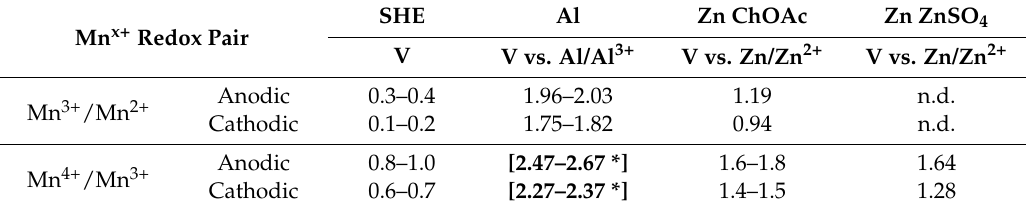
Table 2. Summary of AIB & ZIB (ChOAc & ZnSO 4 ) redox potential region from half-cell measurements in Figure 8; * Extrapolated potential values based on measured redox potentials in ZIB.